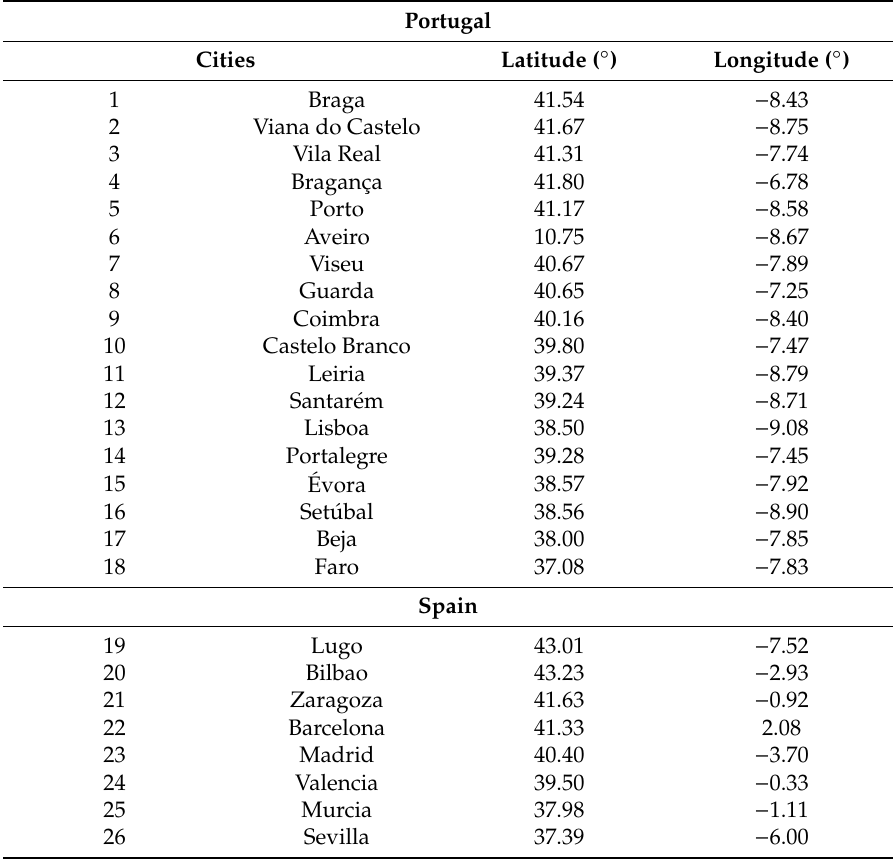
Figure 1. ( a ) The domain used in the Weather Research and Forecasting (WRF) regional implementation, with 81, 27, and 9 km of horizontal resolution [52] and ( b ) division of the studied area per regions in the Iberian Peninsula. Table 1. List of 26 cities considered in this study, along with their corresponding latitude and longitude (negative values of longitude refer to western